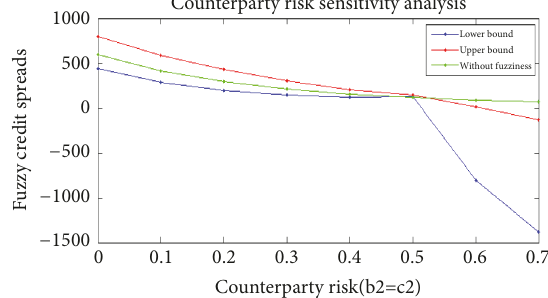
Figure 3: The dynamics between fuzzy credit spreads and fuzzy degree of counterparty risk.